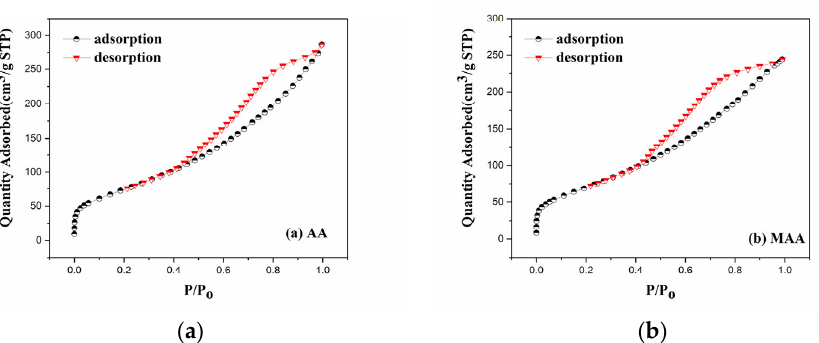
Figure 2. N 2 adsorption ‐ desorption isotherm plot of fresh AA ( a ) and MAA ( b ) from BET analysis.